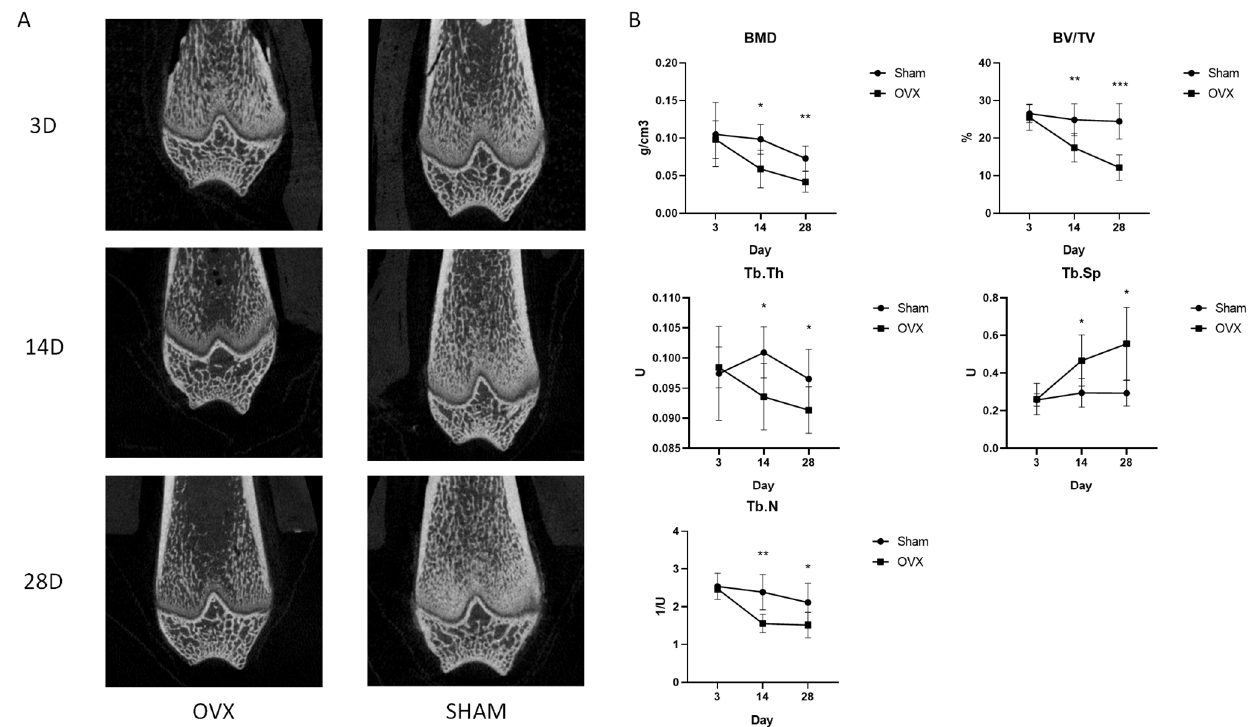
Figure 1. Construction of osteoporosis model. ( A ) The typical microCT 2D images of femurs. ( B ) The microarchitecture parameters of bone in the distal femurs of rats after OVX surgery, including bone mineral density (BMD, unit: g/cm 3 ), bone volume fraction (BV/TV, unit: %), trabecular thickness (Tb.Th, unit: U), trabecular spacing (Tb.Sp, unit: U), and trabecular number (Tb,N, unit: 1/U). * p < 0.05, ** p < 0.01, *** p < 0.001.